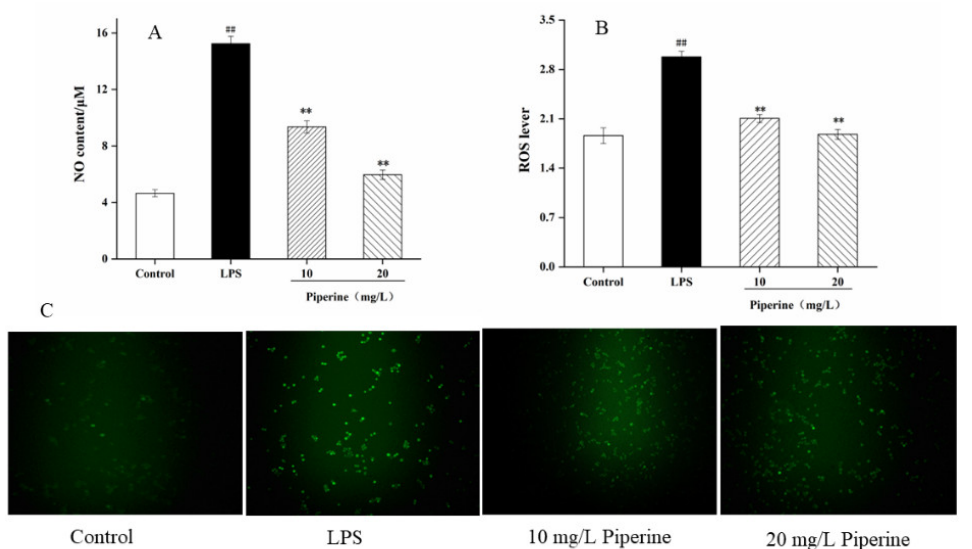
Figure 3. Piperine suppressed the secretion of NO and ROS. ( A ) NO secretion; ( B ) ROS lever analysis of intracellular formation; ( C ) ROS measured by Fluorescence microscopy. Ave ± SD ## p < 0.01 vs. control group; ** p < 0.01 vs. LPS group.